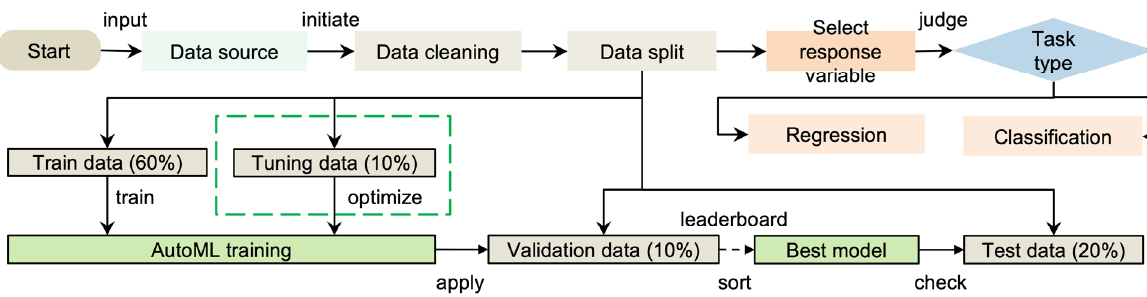
Figure 2. H2O-AutoML